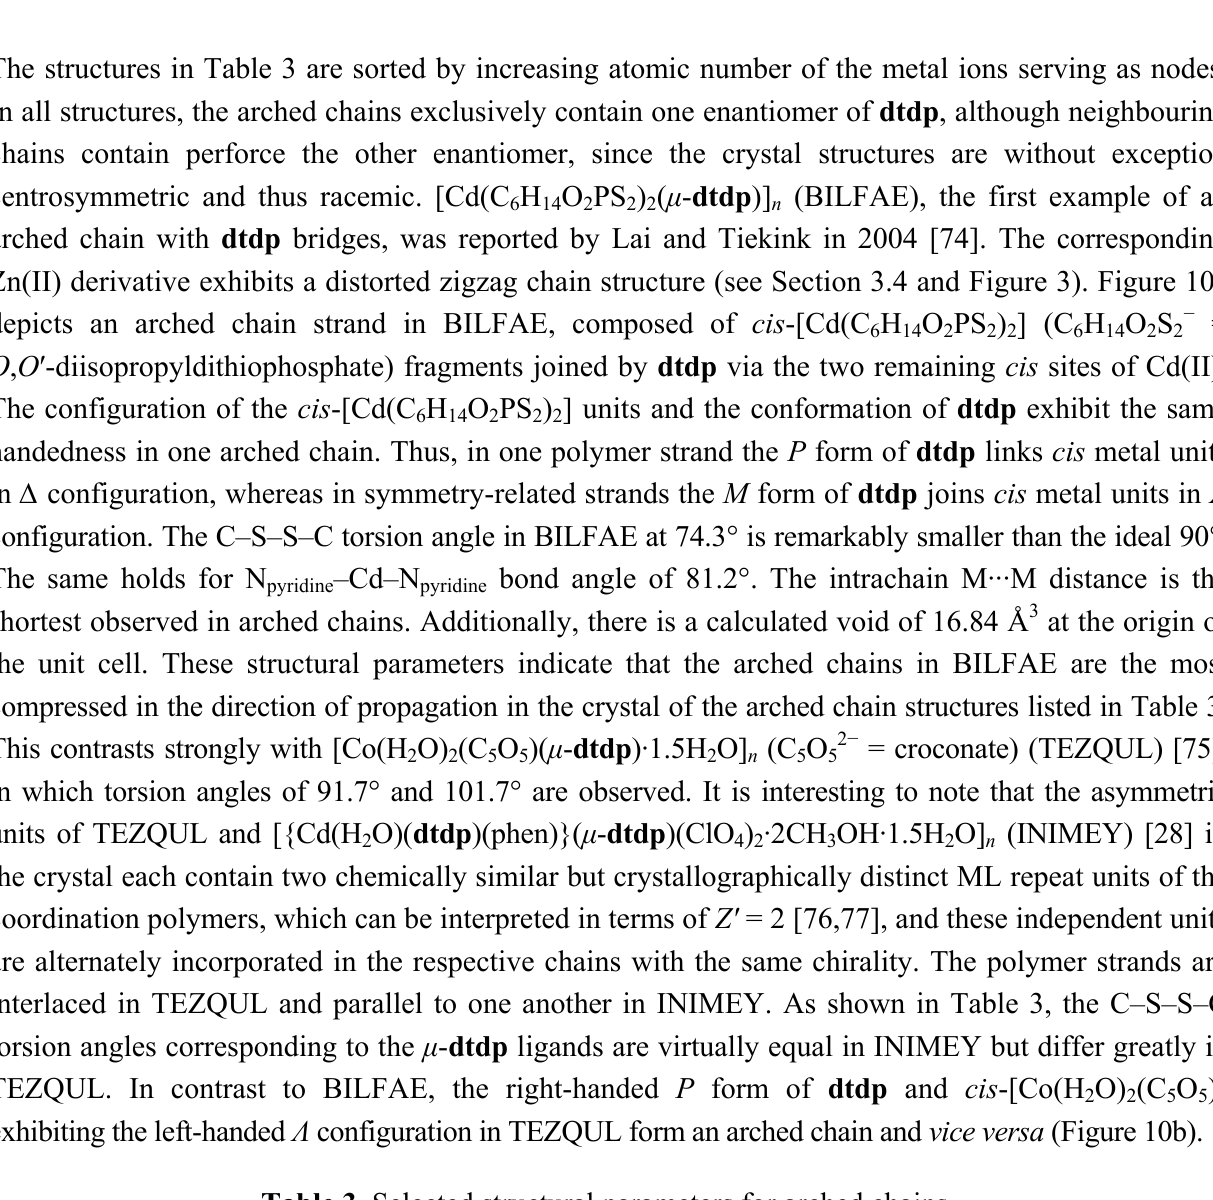
Table 3. Selected structural parameters for arched